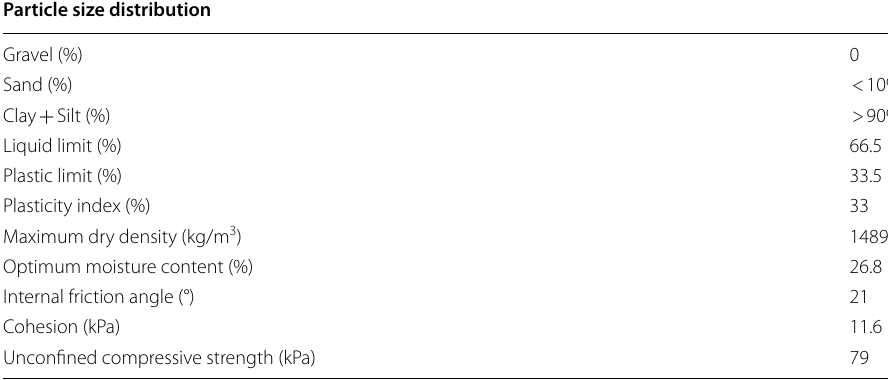
Table 2 Properties of raw soil